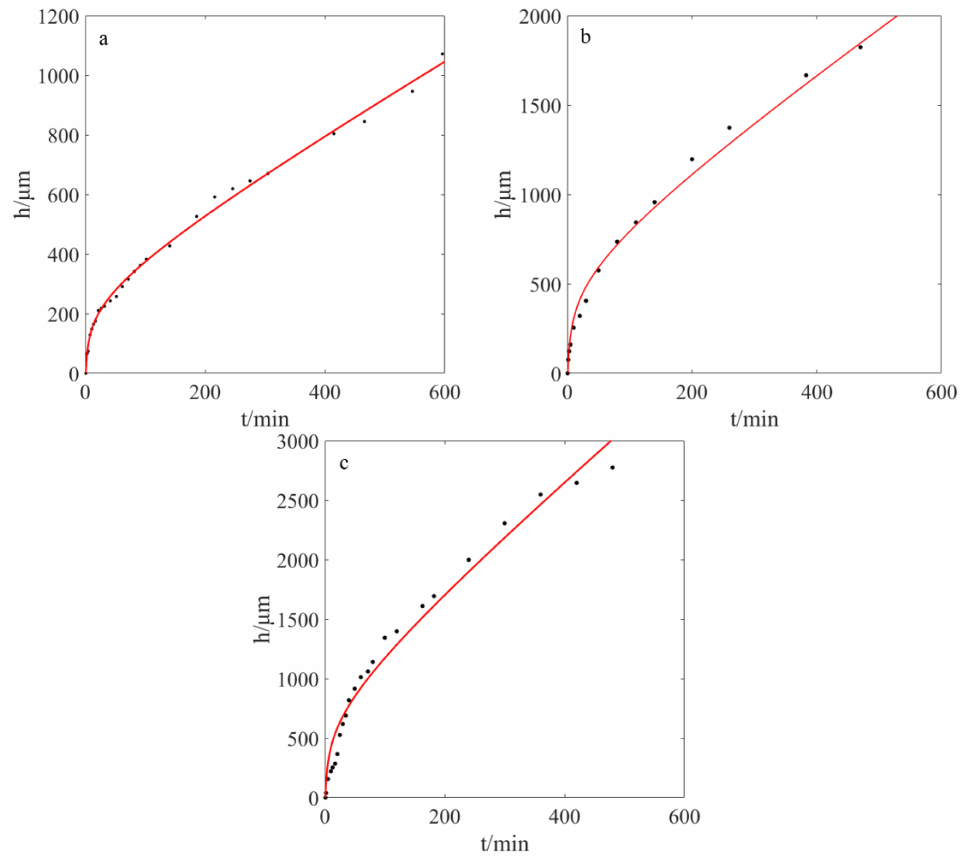
Figure 6. The relationship between gel height and swelling time at different temperatures. ( a ): 10 ◦ C ( b ): 25 ◦ C ( c ): 40 ◦ C (the black dots are experiment data, and the red curves are simulated